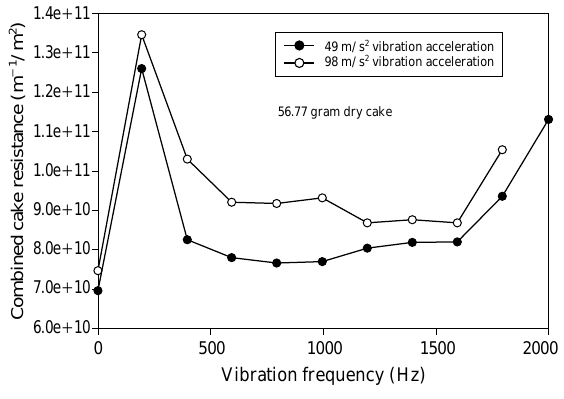
Fig. 15 Combined cake resistance under different vibration fre- quency and acceleration conditions during permeation